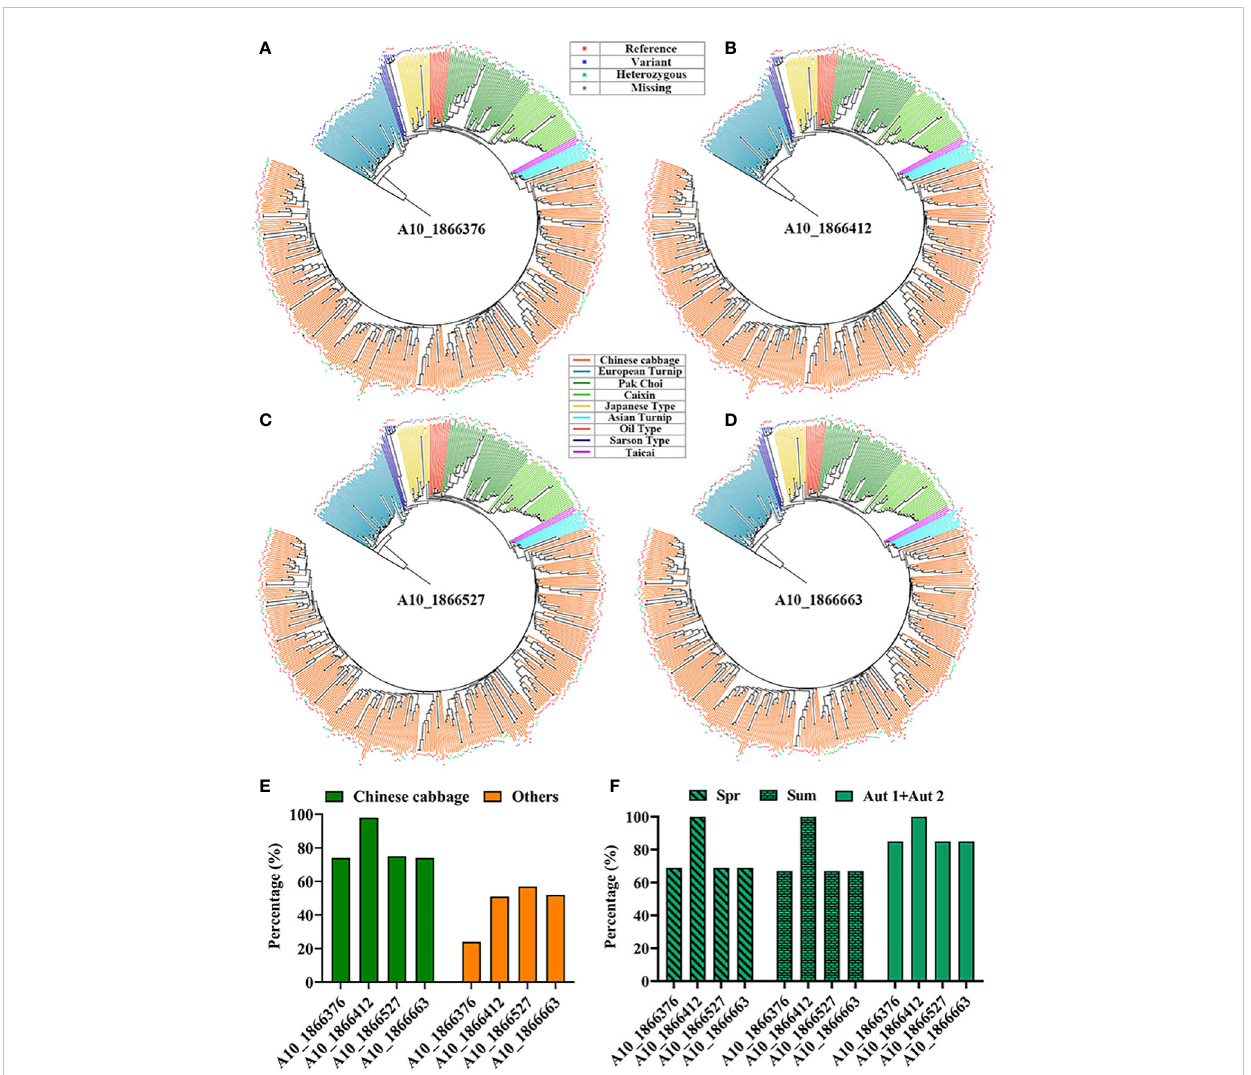
FIGURE 1 Genotypic analyses of SNPs in the BR1 gene region. (A-D) Different SNP types identi fi ed across 524 B rapa accessions in the BR1 gene region. If a particular accession was consistent with the reference genome, this is denoted by a reference designation, whereas the variant designation was used to indicate an accession with a genotype divergent from the reference genome. Deletion events were designated by ‘ Missing ’ , and heterozygous typing was represented by ‘ Heterozygous ’ . (E) The percentage of sequence conservation in Chinese cabbage and other accessions. (F) Percentage of sequence conservation in different Chinese cabbage ecotypes, with Spr and Sum respectively corresponding to the spring and summer ecotypes, while the autumn ecotypes are denoted by